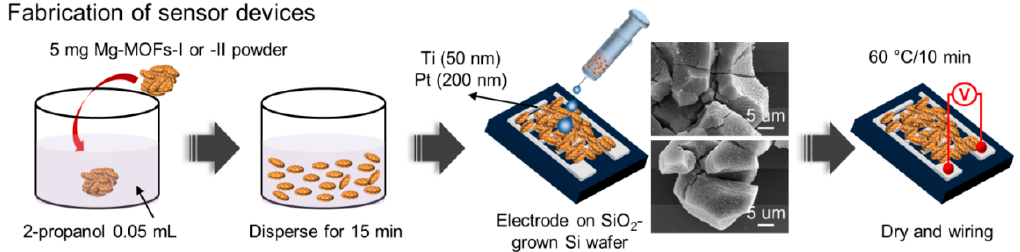
Figure 1. Schematic diagram of the procedure used to fabricate a sensor device with Mg-incorporated metal–organic frameworks